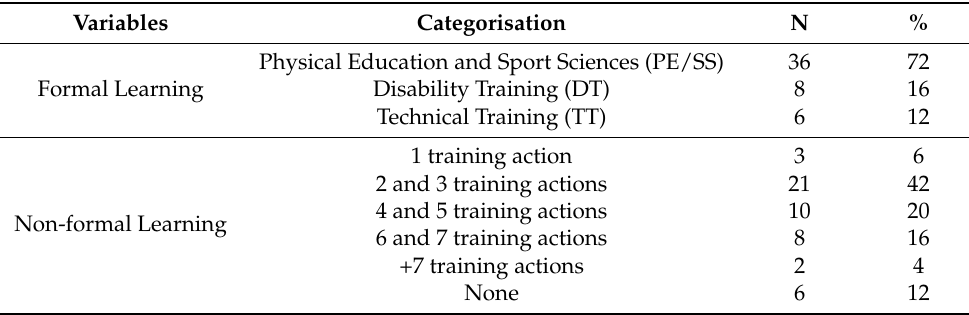
Table 1. Categorization of formal and non-formal learning training